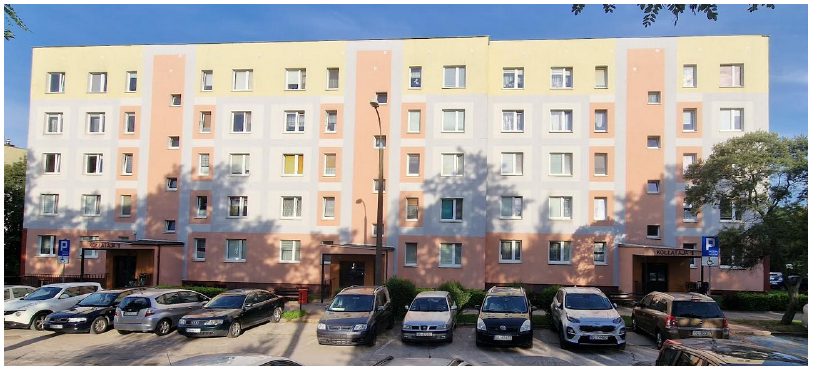
Figure 1. View of a typical building (B19) accepted for the study, made with OWT -67N large-panel prefabricated technology, 5-story, 3-cage [photo taken by authors].